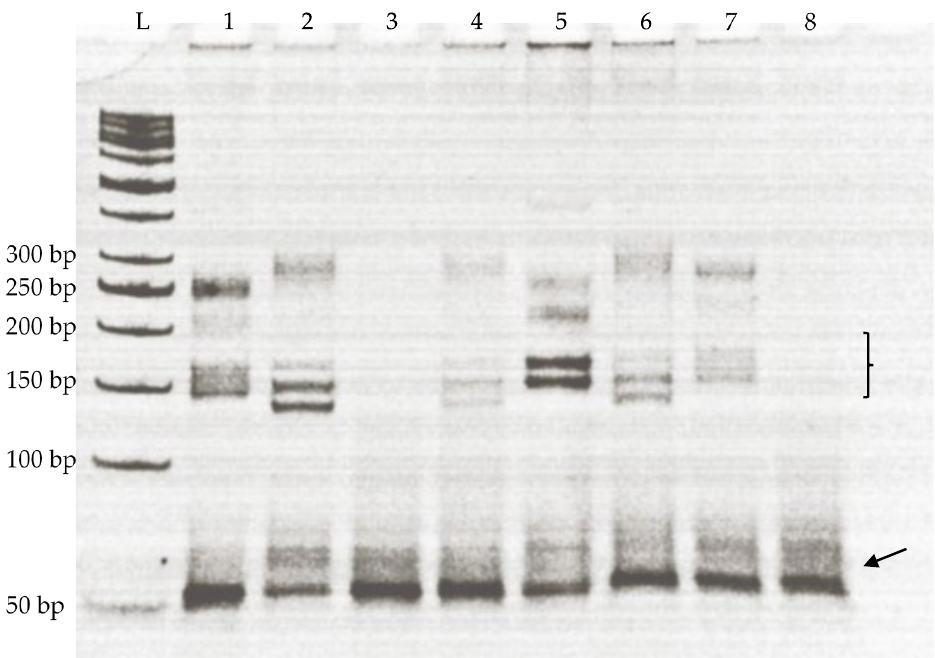
Figure 1. A representative image of polyacrylamide gel electrophoresis showing microsatellite banding pattern in eight individuals of Kari sheep. The sizes of the PCR product bands in samples (1–8) were calculated from the 50 bp ladder (L). Arrow indicates the primer dimmers. Bracket indicates the bands that came in the size range of the given microsatellite marker. Different size bands within the range were considered as different alleles for the marker. The non-specific bands above the expected region of the gel were not included in the